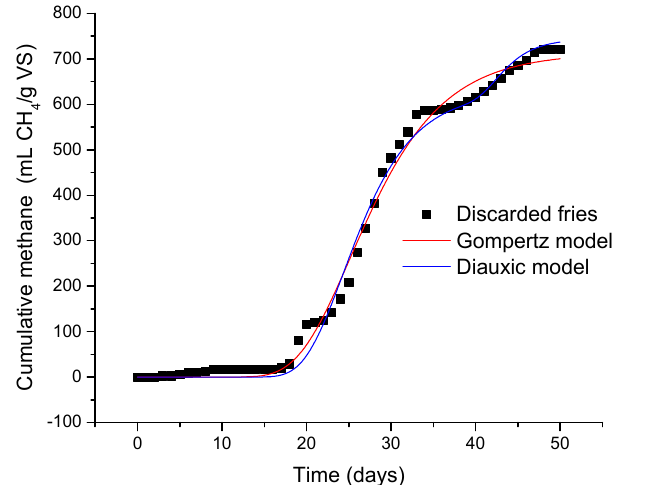
Figure 4. Representation of fitted curves for modified and diauxic Gompertz models proposed by Gomes et al. [24].